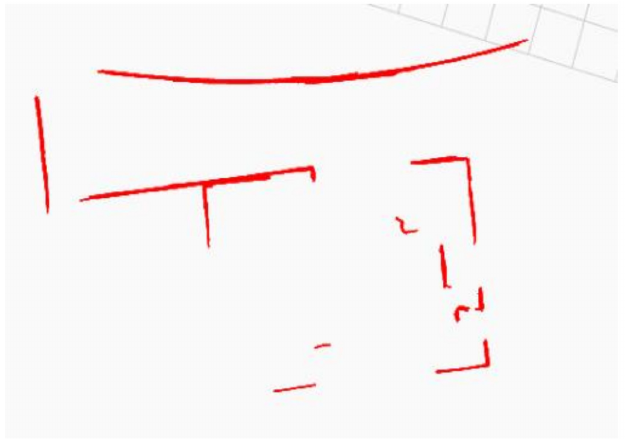
Figure 11. The map of a part of the Intel data set showing the curved and straight walls repre- sented using FALKO-SVED-PDM. The map contains the B-spline segments with approximation error E curve ≤ 0.01.